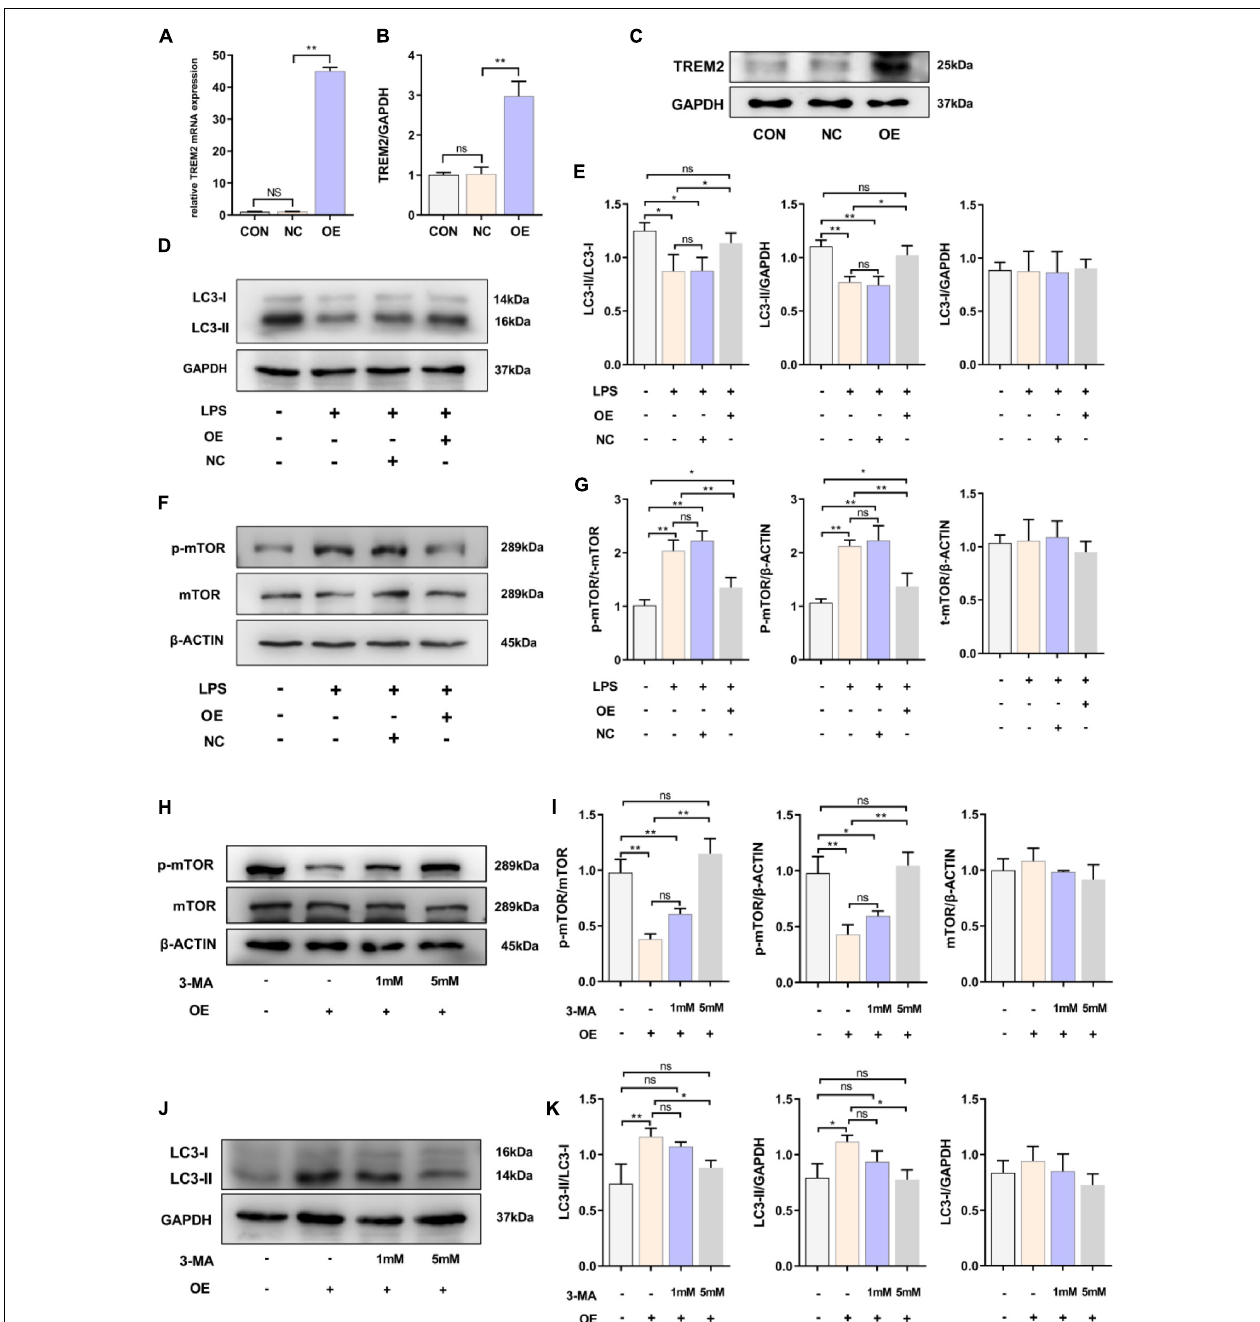
FIGURE 2 | Overexpression of TREM2 significantly increased the autophagy level and suppressed the p-mTOR level of BV2 cells treated with LPS. (A) After BV2 cells were transfected with plasmid 24 h, the mRNA expression level of TREM2 was detected by qPCR ( n = 3/group). (B,C) The expression level of TREM2 protein after transfection of plasmid was detected by WB ( n = 3/group), and the expression level of TREM2 protein was analyzed by quantitative analysis of protein ( F = 30.38). (D,E) The expression level of LC3 protein after transfection of plasmid was detected by WB ( n = 3/group), and the expression of LC3II and LC3I was analyzed by quantitative analysis of protein, the ratio of LC3II/LC3I was shown ( F = 8.04). (F,G) The expression level of p-mTOR and mTOR protein after transfection of plasmid was detected by WB ( n = 3/group), and the expression of p-mTOR and mTOR were analyzed by quantitative analysis of protein, the ratio of p-mTOR/mTOR was shown ( F = 31.84). (H) After the cells were transfected with plasmids, the cells were treated with 1 or 5 mM 3-MA for 24 h, the expression level of p-mTOR and mTOR protein was detected by WB. (I) The ratio of p-mTOR/mTOR was shown ( F = 39.48). (J) After the cells were transfected with plasmids and treated with 3-MA, the LC3 was detected by WB ( n = 3/group). (K) The ratio of LC3II/LC3I was shown ( F = 10.19). NC stands for transfection of pEGFP-C1 (empty-plasmid). OE stands for transfection of TREM2-plasmid. All the quantitative analysis of protein was done by Image J to calculate the gray value. Data are shown as the mean ± SE. The fold change is significant where * P < 0.05, ** P < 0.01. n = number of independent cell culture preparations.